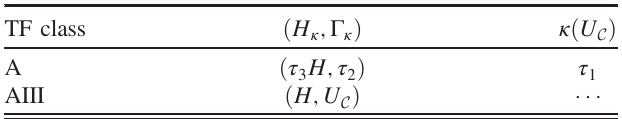
TABLE XVIII. The mapped Hamiltonian (B5) and the repre-